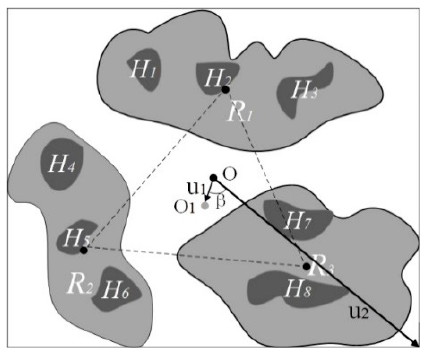
Figure 4. Revolution of CPPG.